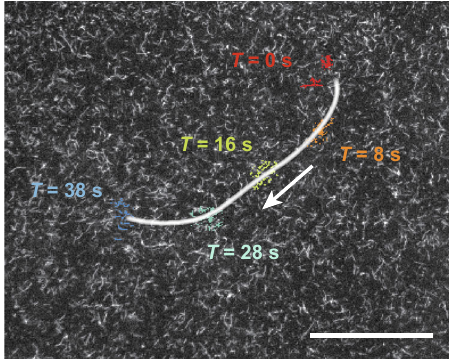
Fig. 1 Time trace of ‘ seeds ’ . Premature and unstable small clusters, termed ‘ seeds ’ contain several fi laments, which display a coordinated motion that persists only for a short while. Even before the transition of the system to the distinctive polar ordered state — stable clusters — there are signs of local ordering. However, the direct visualization and hence the quantitative analysis of such seeds are unrealistic due to the absence of signi fi cant intensity difference (see Supplementary Movie 1 for the movie of the time trace; the seeds are barely visible). Time trace taken ≈ 3 min after adding ATP and ρ ≈ 5.7 fi laments μ m − 2 . Scale bar: 50 μ